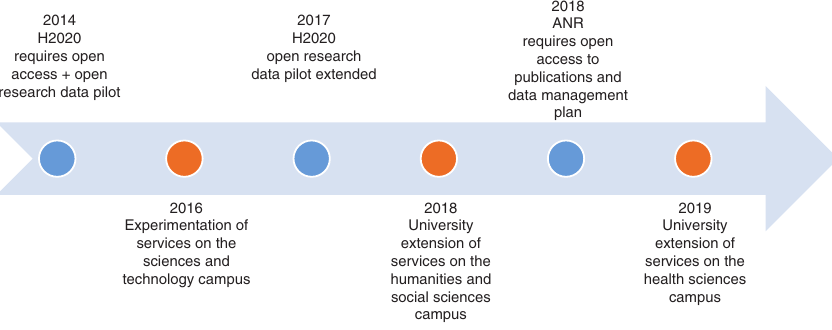
Fig. 1: Timeline of the extension of the support of H2020 and ANR projects by the Library.